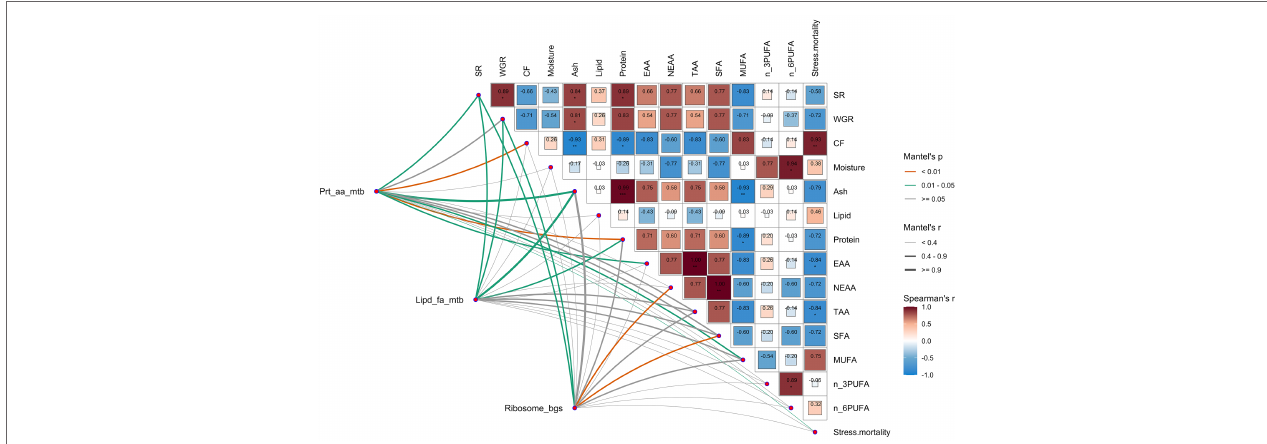
FIGURE 4 | Multidimensional correlation analysis between gene expression and larval nutrition parameters. Nutritional parameters: survival rate (SR), weight gain rate (WGR), condition factor (CF), larval body moisture, ash, lipid, protein, essential amino acid content (EAA), nonessential amino acid content (NEAAs), total amino acid content (TAAs), saturated fatty acids (SFAs), monounsaturated fatty acids (MUFAs), n-3 polyunsaturated fatty acids (n_3PUFAs), n-6 polyunsaturated fatty acids (n_6PUFAs) and stress resistance to hypoxia stress (stress mortality). Gene expression: hepatic protein and amino acid metabolism-related gene expression, including pro1 , mata2 , gs , oct , aldh18a1 , csb , and gpt2 (Prt_aa_mtb); hepatic lipid and fatty acid metabolism-related gene expression, including acat2 , crls , me , aacs , lpin2 , elovl5 , mgll , acsbg2 , acsl6 , and pemt (Lipd_fa_mtb); hepatic ribosome biogenesis-related gene expression, including rpf2 , polr1d , nop60b , mrpl2 , mrSL12 , mrpl16 , nop56 , nop58 , bop1 and mrt4 (Ribosome_bgs). Pairwise comparisons of nutritional parameters are presented, with a color gradient and color block size denoting Pearson’s correlation coefficients. Related gene expression levels were related to the characterized parameters by Mantel’s tests. The edge width and color correspond to Mantel’s r statistic and Mantel’s p statistic for the corresponding distance correlations,